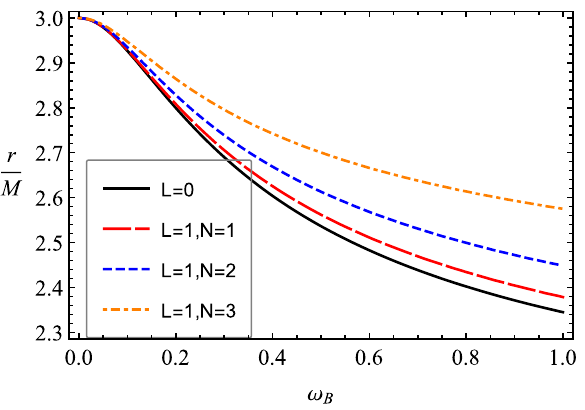
Fig. 5 Dependence of the minimum circular orbits from the magnetic interaction parameter (cyclotron frequency) ω B for the different values of the conformal parameters L and N with the comparison of pure Schwarzschild case (black solid line)